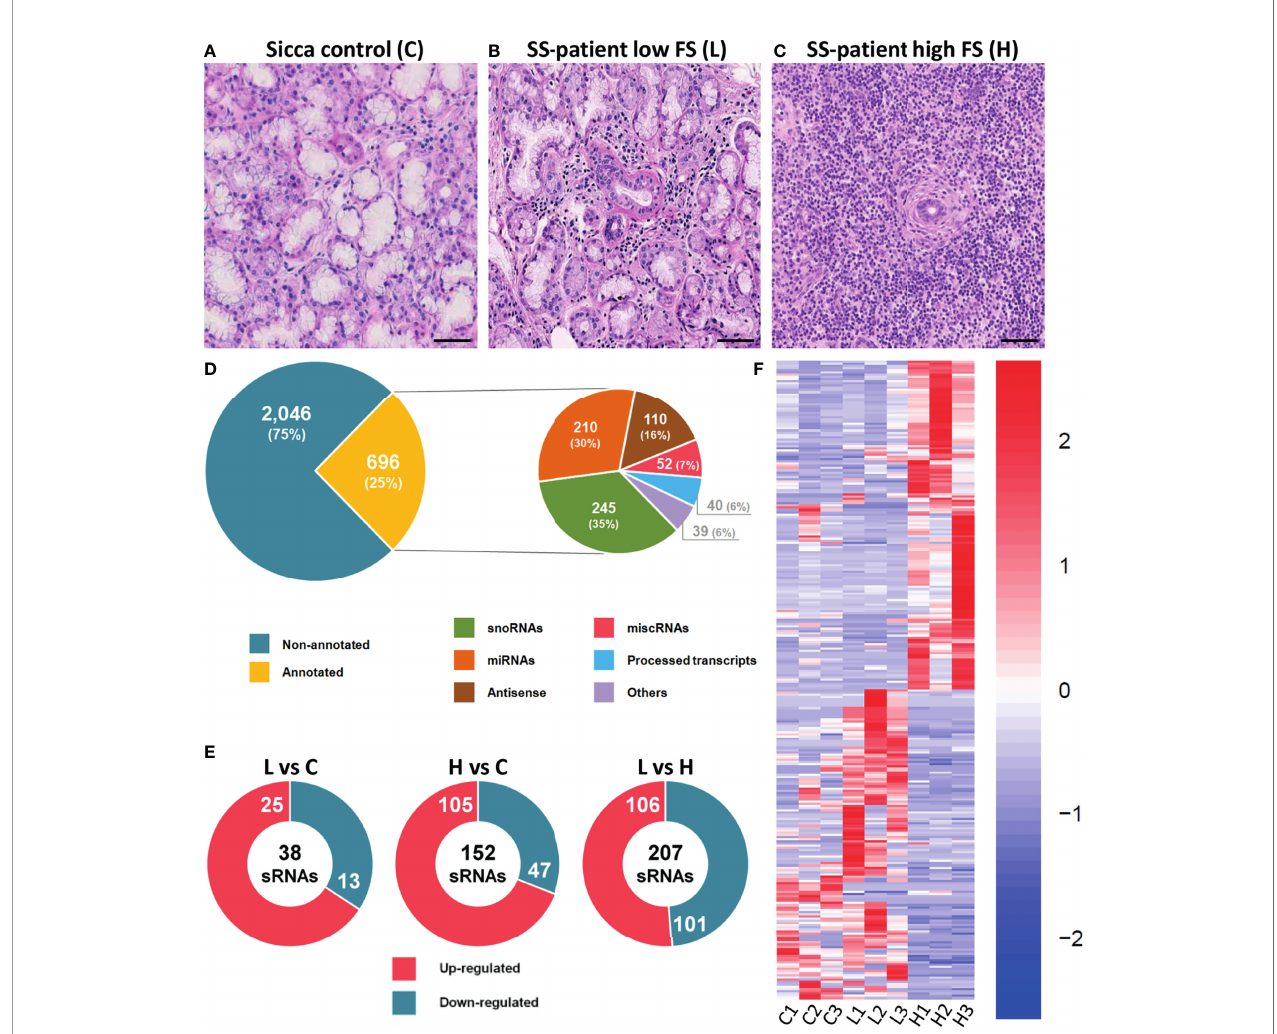
FIGURE 1 | Global pro fi le of small RNAs detected in LSG using NGS. (A – C) Histology of LSG from a representative sicca control, SS-patients with low focus score (L), and SS-patients with high focus score (H). (D) Total number of annotated and non-annotated sRNAs (left) and subgroups of snoRNAs, miRNAs, antisense, miscRNAs, processed transcripts and others are presented (right). (E) Number of sRNAs up-regulated or down-regulated in LSG from SS-patients with low (L) or high (H) focus score compared to sicca controls (C) . (F) Heat map of differentially expressed sRNAs in LSG from controls and SS-patients with low and high focus score. The rows of the heat map represent sRNAs, while the columns represent different LSG samples. The fi lter used was Log2FC=|2| and p-value ≤